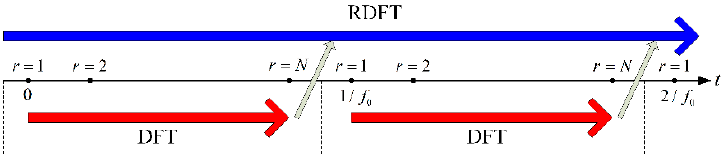
Figure 3. The method to prevent round-off error accumulation.